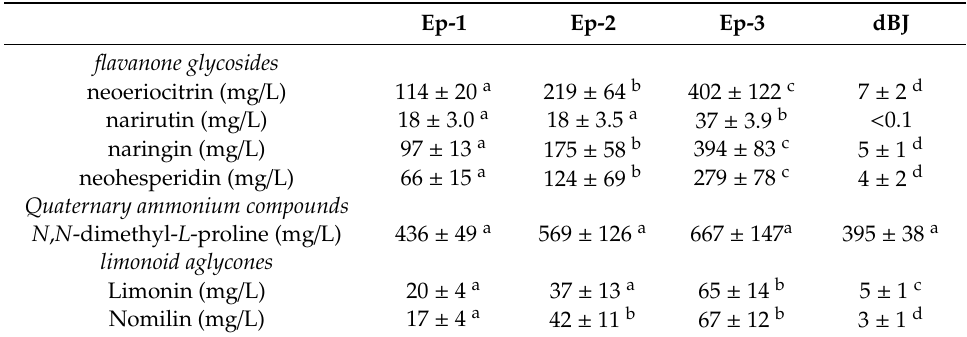
Figure 2. Comparison of RP-HPLC-DAD chromatograms at 284 nm of flavanone glycosides in bergamot juice (BJ) obtained using 3 processing methods: ( a ) Standard mixture of eriocitrin (1), neoeriocitrin (2), narirutin (3), naringin (4), hesperidin (5), neohesperidin (6). ( b ) Hand squeezed BJ (Ep-1); ( c ) FMC–BJ (Ep-2); ( d ) BJ obtained by screw press of peeled fruits (Ep-3); ( e ) debittered bergamot juice (dBJ). Table 2. Concentration (mean ± standard deviation, n = 3) of flavanone glycosides, quaternary ammonium compounds, and limonoid aglycones in bergamot juice obtained using 3 di ff erent juice extraction methods: hand squeezing (Ep-1); FMC (Ep-2); screw press of peeled fruits (Ep-3), and in debittered bergamot juice